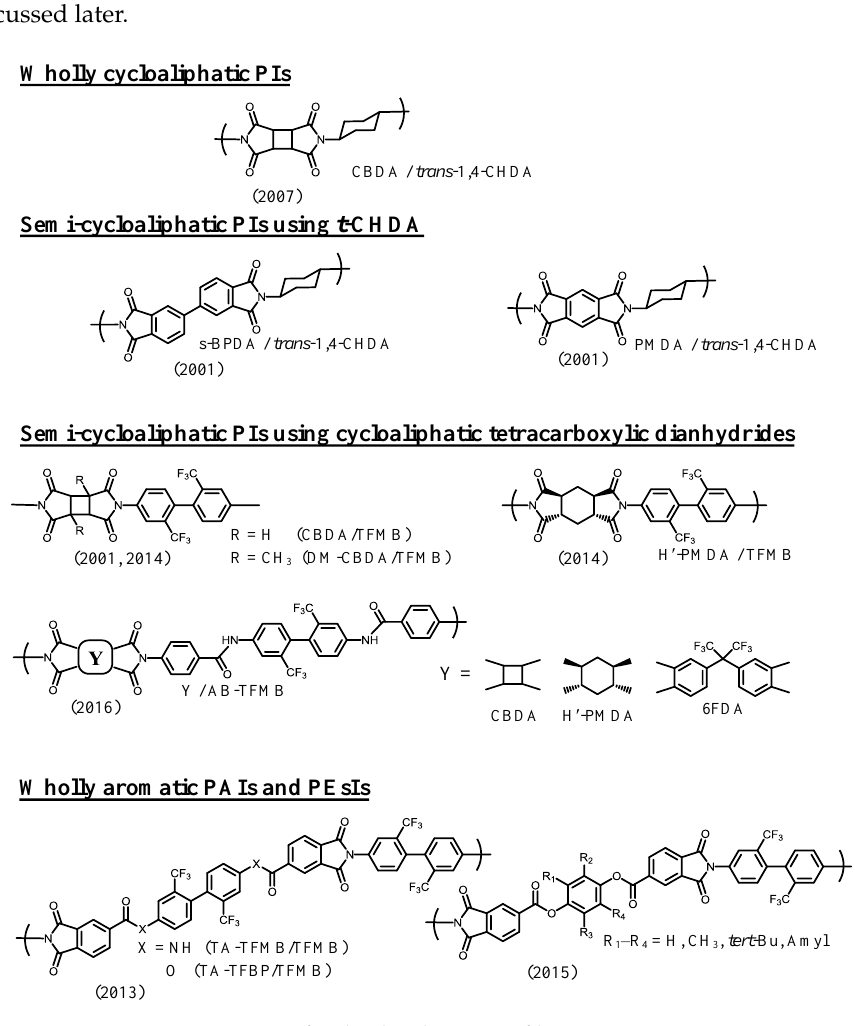
Figure 7. A transition for the development of low-CTE transparent PIs.